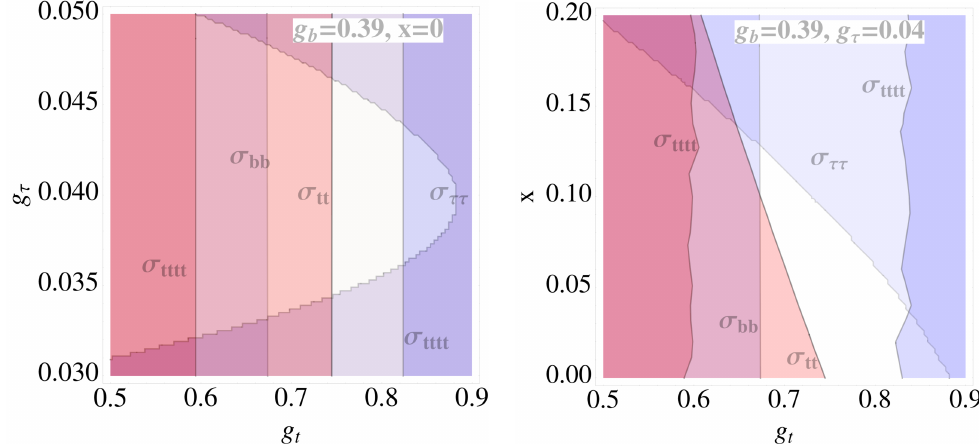
Figure 2 . Production cross-section predictions of relevant 400-GeV pseudoscalar channels with 1 σ uncertainties in the [ g , g ] (with x = 0 and g = 0.39) and [ g , x ] ( g = 0.04 and g = 0.39) planes, t τ b t τ b left and right panels, respectively. Each contour line is labeled with the 1 σ cross-section value of the corresponding considered channel. Blue and red shaded areas are excluded by